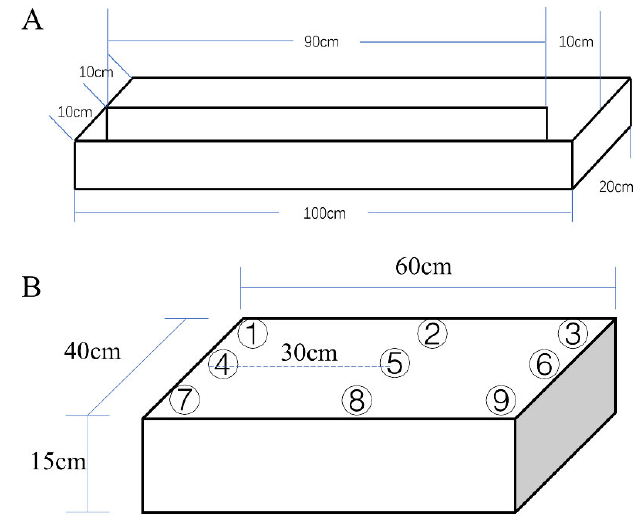
Figure 6. ( A ) Schematic diagram of the U-shaped water tank. ( B ) Schematic diagram of the plastic box used to simulate the paddy field system. The numbers in the figure represent nine sampling points at different locations.